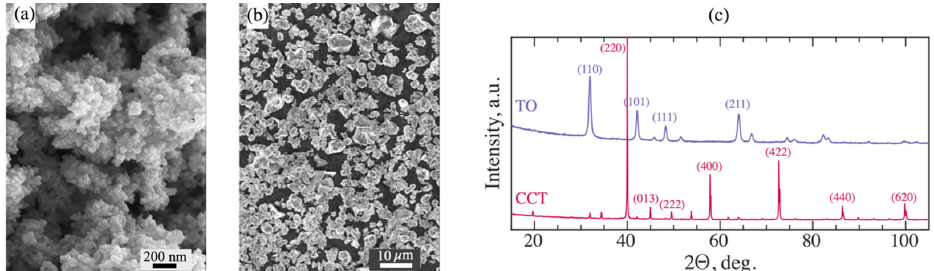
Figure 2 . SEM images of raw titanium oxide (TO) ( a ) and calcium copper titanate (CCT) particles ( b ); and ( c ) XRD patterns of corresponding TO and CCT nano- and micro-particles.